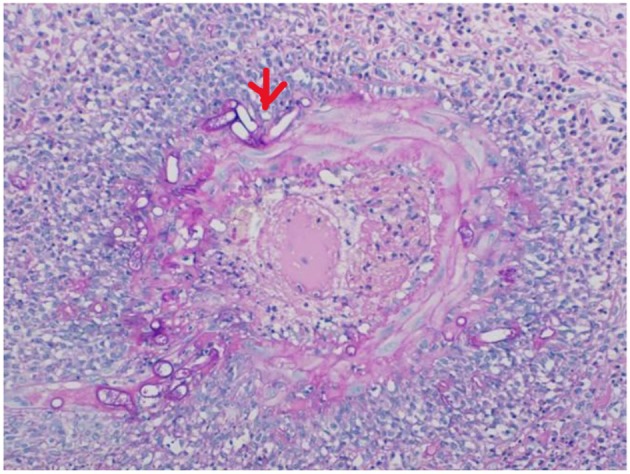
HE stain of the excised bowel. Splendore Hoeppli (see red arrow).